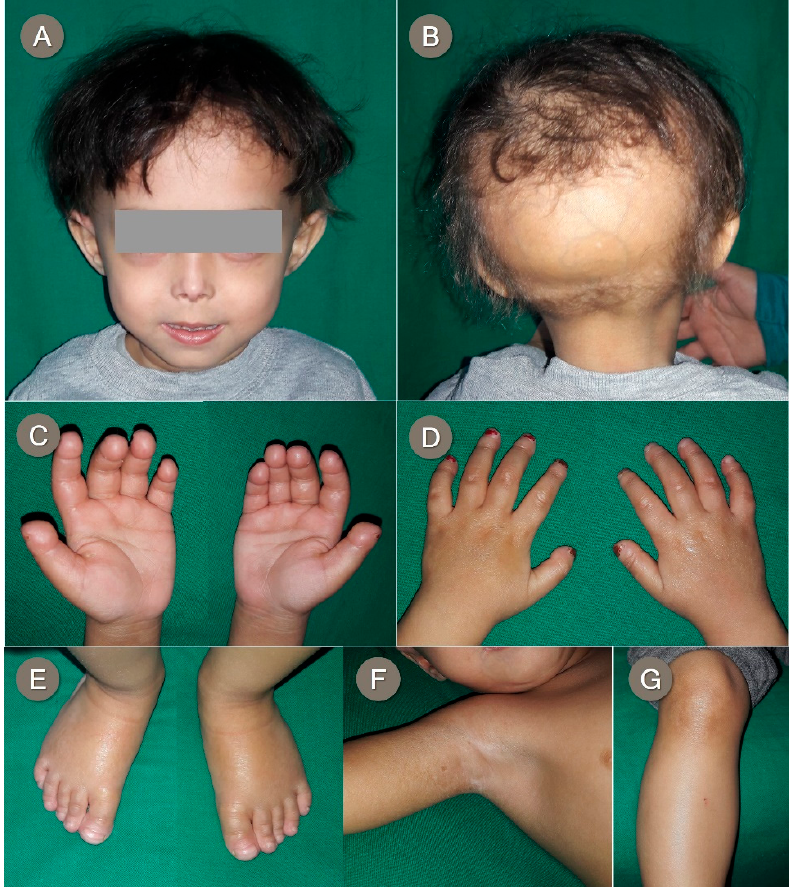
Figure 3. Proband 3 shows a receding anterior hairline; scanty scalp hair; bulbous cheeks with visible veins; wide eyes with periocular hyperpigmentation; a pointed nose; a small mouth and micrognathia ( A ); occipital alopecia and prominent scalp veins ( B ); round-tipped terminal phalanges of fingers ( C ); atrophic shiny skin on the dorsum of hands and broad, short, dystrophic nails ( D ); mild rounding of toe tips and broad, short nails ( E ); hyperpigmented thin skin over knees ( F ); and hyper- and hypopigmented patches on axilla ( G ).